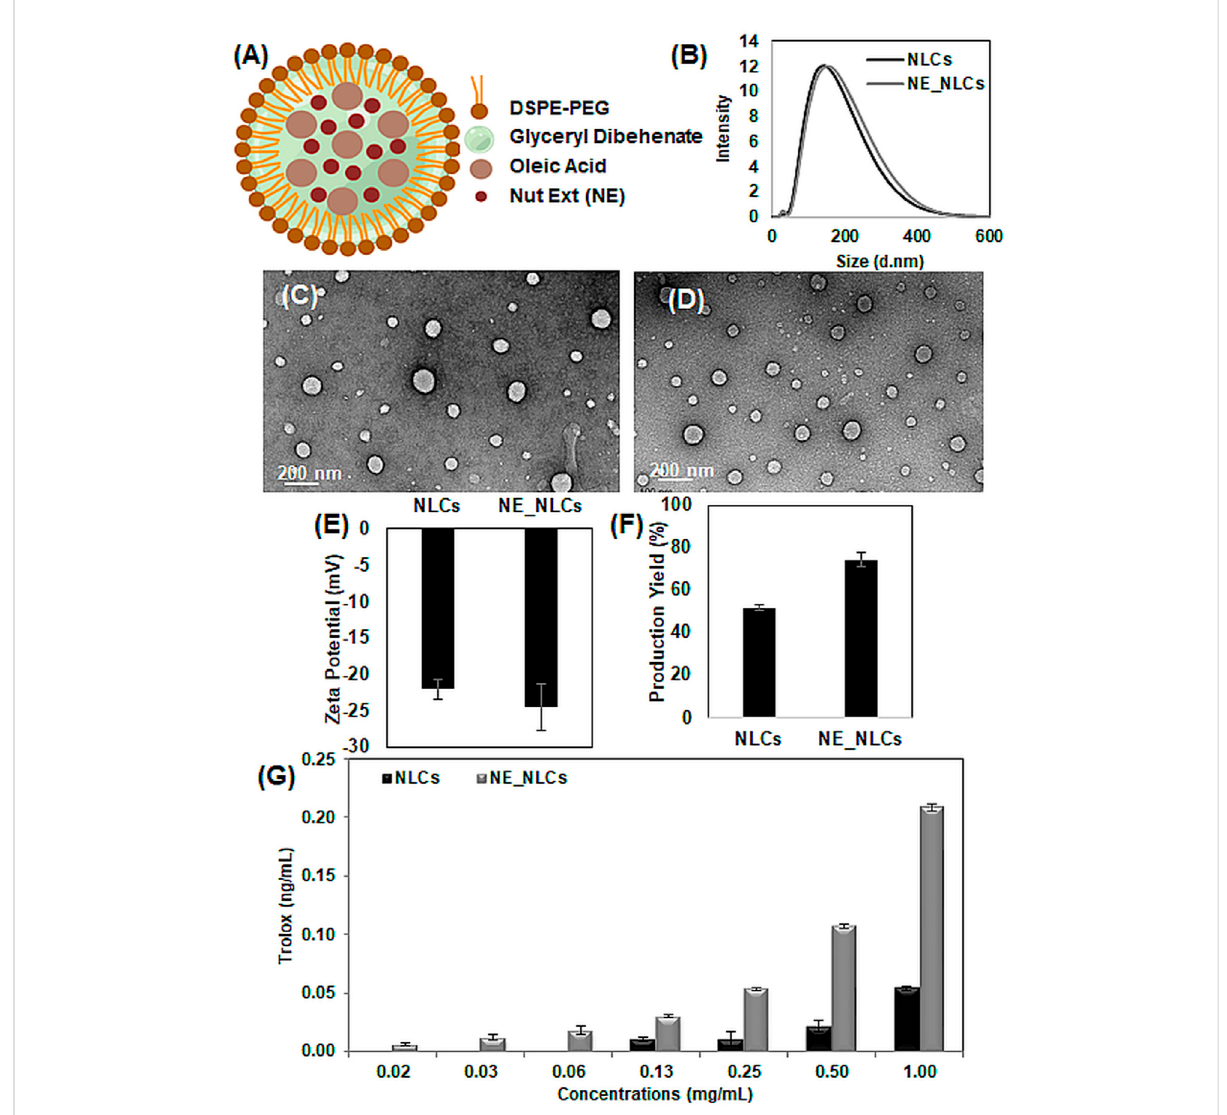
FIGURE 2 Characterization of NLCs and NE_NLCs. Schematic representation ofthe structure ofNE_NLCs (A) ,dynamiclightscattering (B) , representative transmission electron microscopy (TEM) images of NLCs (C) and NE_NLCs (D) , ζ -Potential measurements (E) , and production yield (F) . Total antioxidant capacity of NLCs and NE_NLCs at increasing concentrations expressed as Trolox equivalent (G)